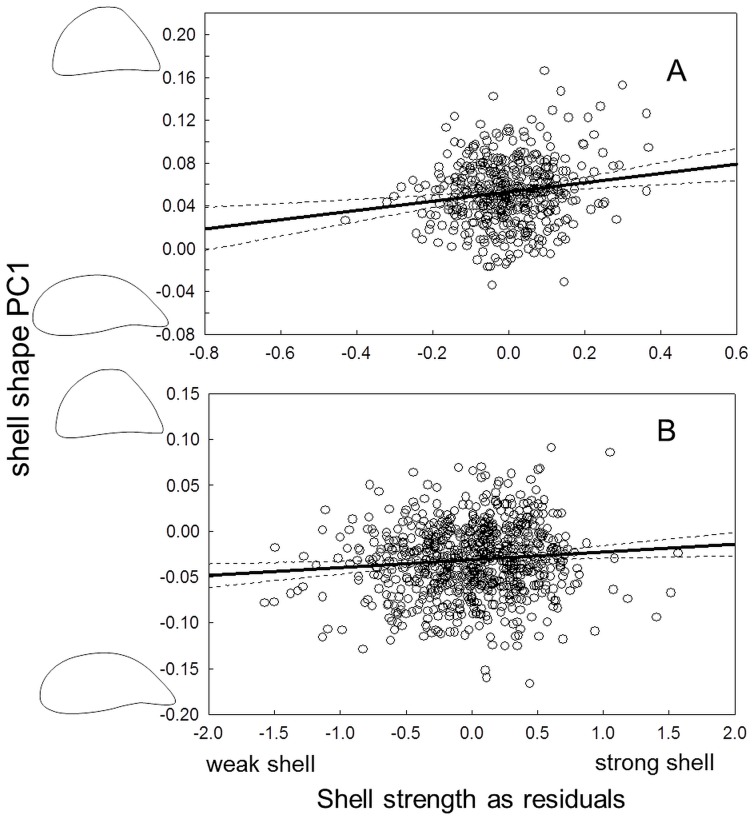
Shell shape and shell strength are correlated in zebra mussels.
A: experimental data from 448 mussels. B: field data from 756 mussels. The contours on the y-axis depict ±2SD of the mean of PC1. Dashed lines denote 95% confidence intervals for the fit. Note that we here present individual values for the experimental mussels since we obtained both a shape and strength measure for each mussel separately.